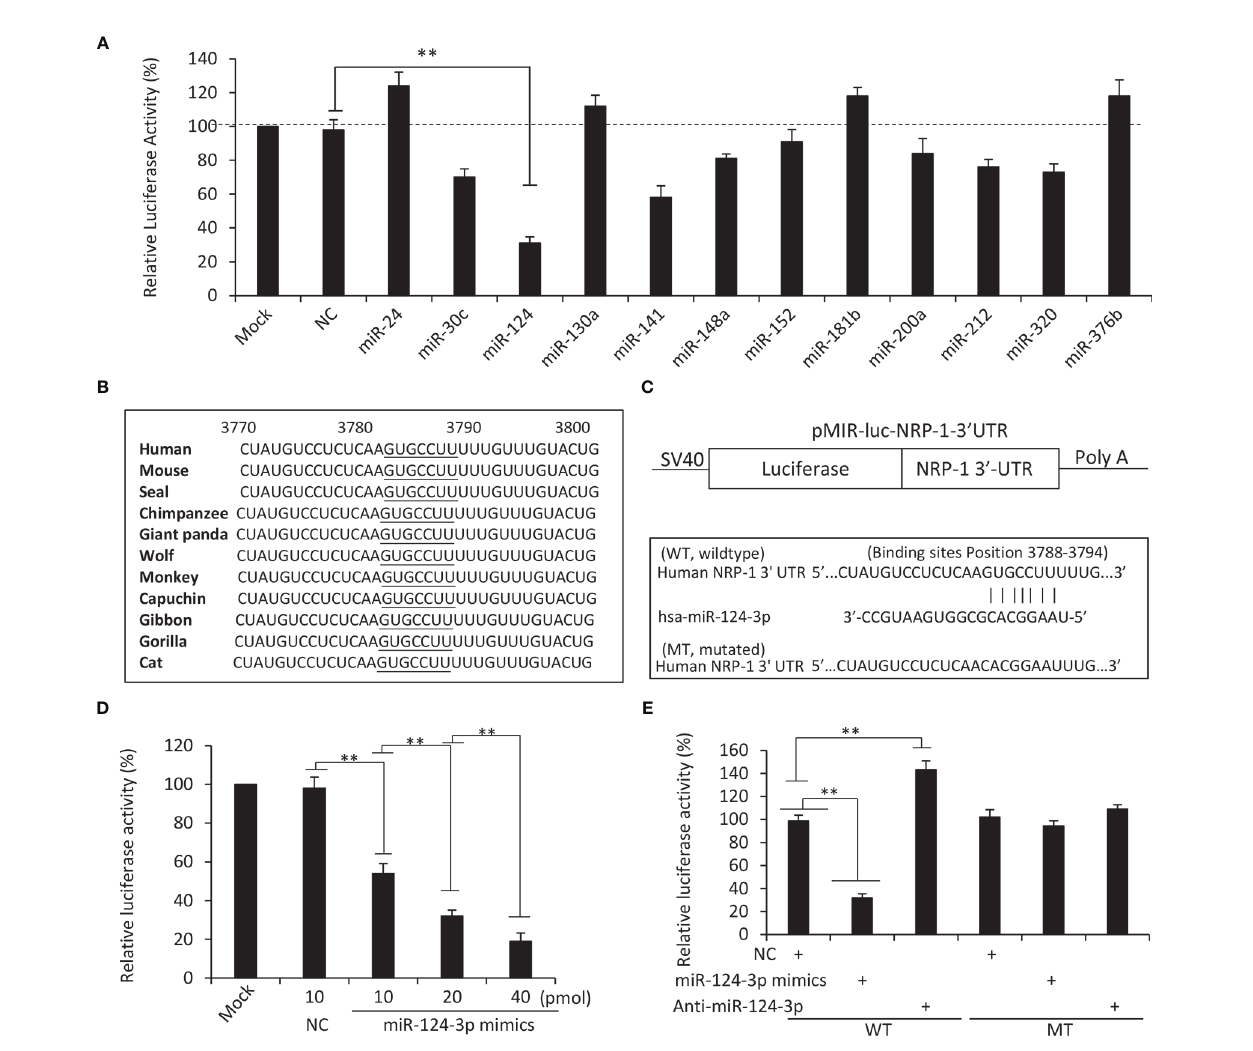
FIGURE 3 | MiR-124-3p regulates NRP-1 expression by binding to the 3 ’ UTR. (A) MDA-MB-231 cells were co-transfected with a luciferase reporter containing sequences of the 3 ’ UTR of human NRP-1 gene with negative control (NC) oligonucleotides or each of the miRNA mimics. Mock-transfected cells served as controls. (B) A highly conserved miR-124-3p binding site on the 3 ’ UTR of NRP1 is observed in all the species. (C) Two luciferase reporter vectors containing the wild-type (WT) or mutated (MT) NRP-1 3 ’ -UTR were constructed. (D) MDA-MB-231 cells were co-transfected with the WT luciferase reporter and miR-124-3p mimics at different concentrations. (E) MDA-MB-231 cells were co-transfected with WT or MT luciferase reporters, and NC, miR-124-3p mimics or antagomiR-124-3p oligonucleotides. Luciferase activities were measured and normalized to untreated cells as a control. “ **P <0.001 ” (one-way ANOVA with a Tukey post-hoc